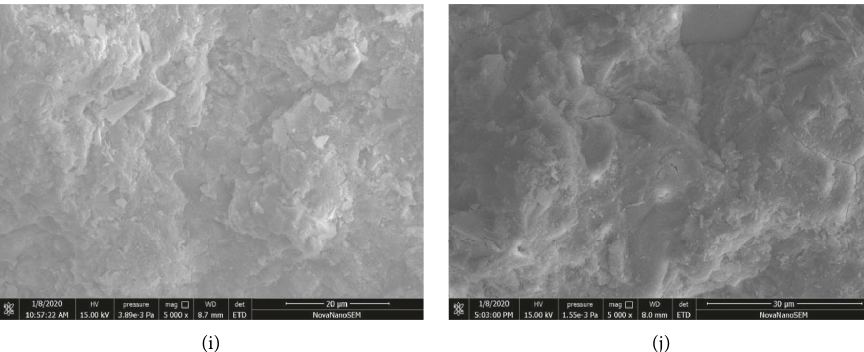
Figure 15: Morphology of microscopic products of coral concrete. (a) TSK without fly ash and silica fume. (b) 5% fly ash +5% silica fume. (c) 5% fly ash +10% silica fume. (d) 5% fly ash +15% silica fume. (e) 10% fly ash +5% silica fume. (f) 10% fly ash +10% silica fume. (g) 10% fly ash +15% silica fume. (h) 5% fly ash +5% silica fume. (i) 15% fly ash +10% silica fume. (j) 15% fly ash +15% silica